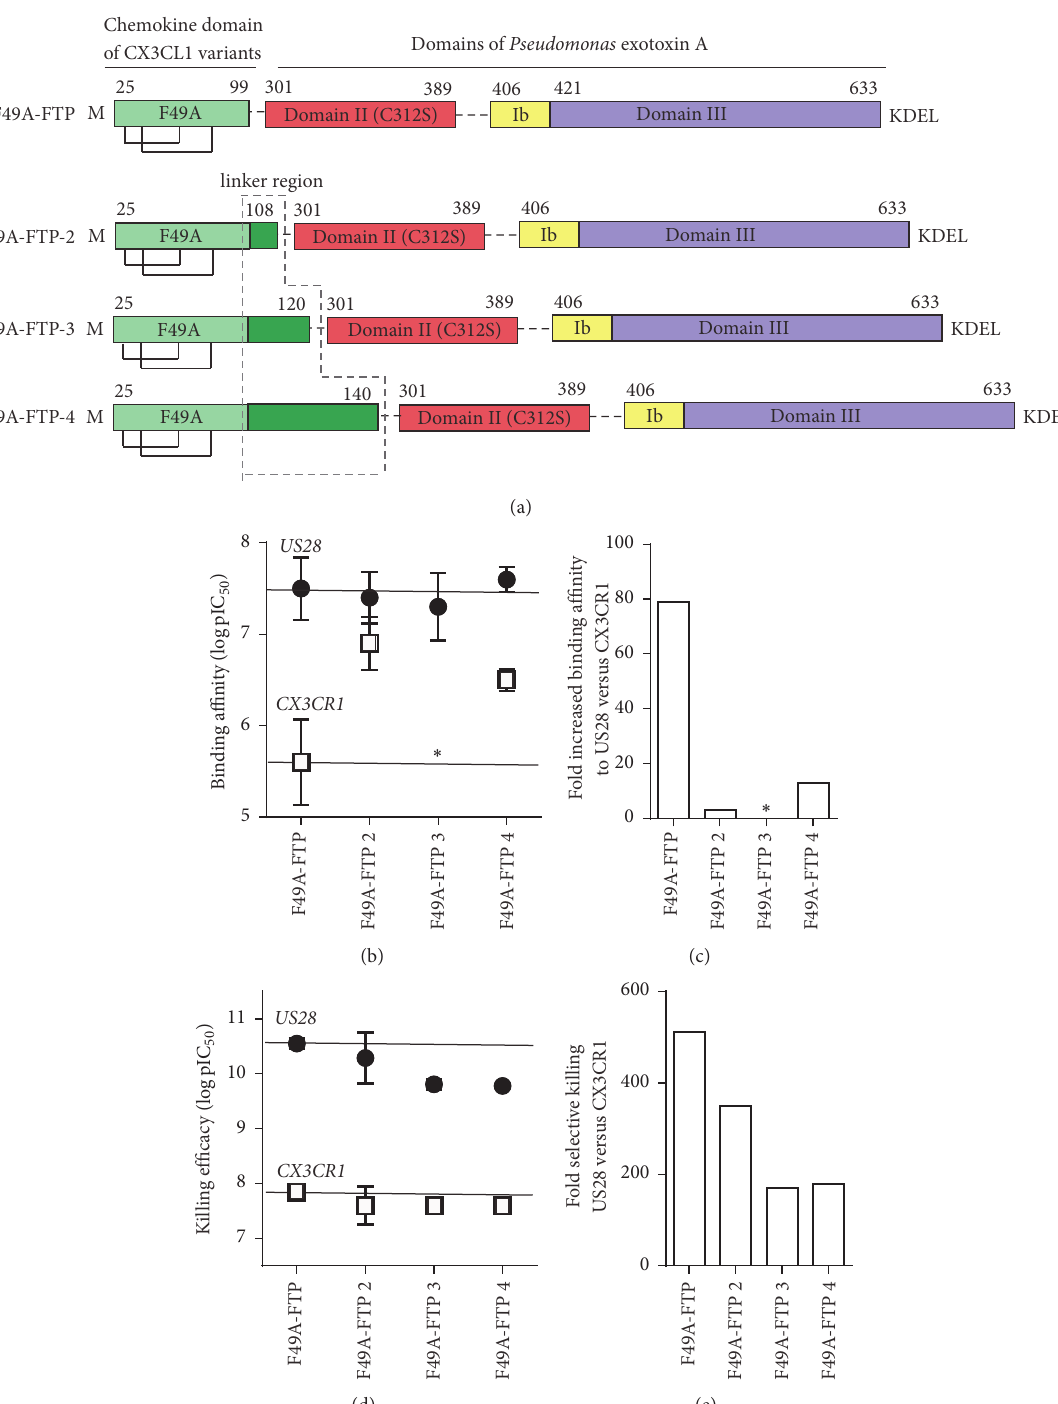
Figure 3: Design, binding, and cell killing of FTPs containing parts of the mucin-like stalk of CX 3 CL1. (a) FTPs with an extended linker consisting of parts of the mucin-like stalk of CX 3 CL1. (b) Binding of F49A-FTP and FTPs from this group on HEK-293 cells induced to express US28 (black circles) and CX 3 CR1 (white squares). The IC 50 value for F49A-FTP-3 is > 10 −6 M (no binding detectable on CX 3 CR1 expressing cells; marked with a star) and the binding selectivity was therefore not analyzed in (c). (c) Binding selectivity determined as fold improved affinity for US28 relative to CX 3 CR1. (d) Cell killing of F49A-FTP and FTPs from this group on tetracycline induced HEK-293 cells expressing US28 (black circles) and CX 3 CR1 (white squares). (e) Selectivity of F49A-FTP and FTPs from this group determined as fold improved potency in killing US28- relative to CX 3 CR1-expressing cells. Values present IC 50 values from 3–5 independent biological replicates (b) and